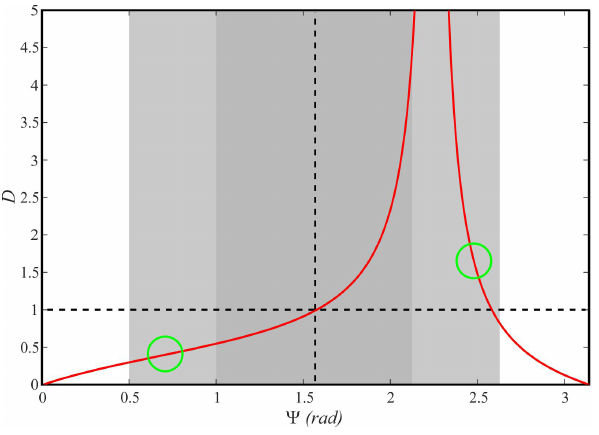
Figure A1. Example of distortion expected between measured and simulated λ Z , in relation to the GW parameters derived from the GPS RO event above the Andes, as detailed in Figs. 8, 9, and 10. Both green circles illustrate, for a given α value, possible D – ψ combinations of the parameters that would correspond to under- (left green circle) and overestimation (right circle) of λ Z